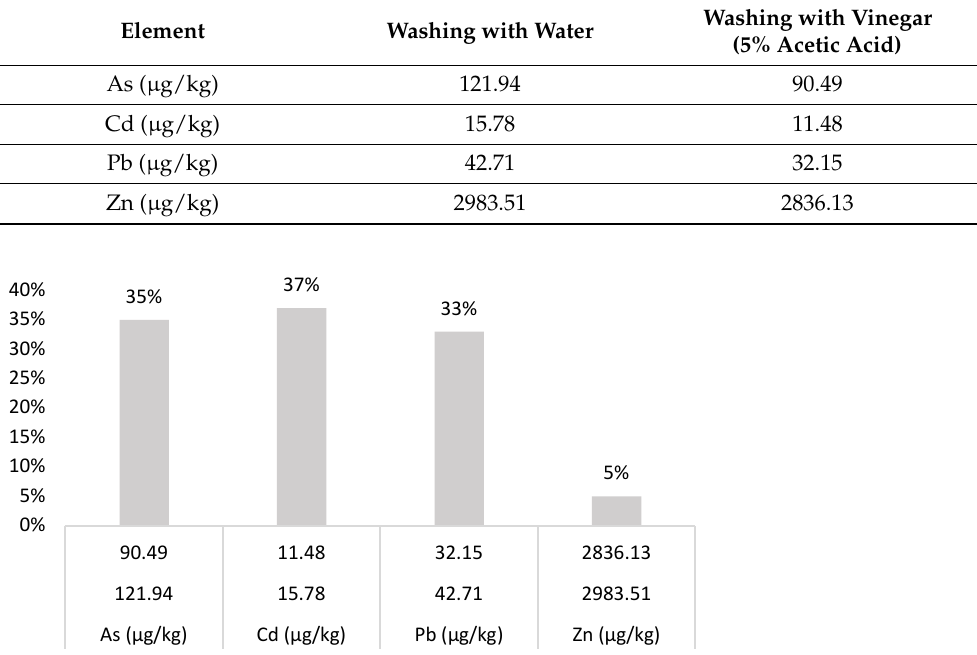
Table 5. The concentration of heavy metals analyzed in samples of fruit and vegetables washed with tap water and vinegar (10% acetic acid).